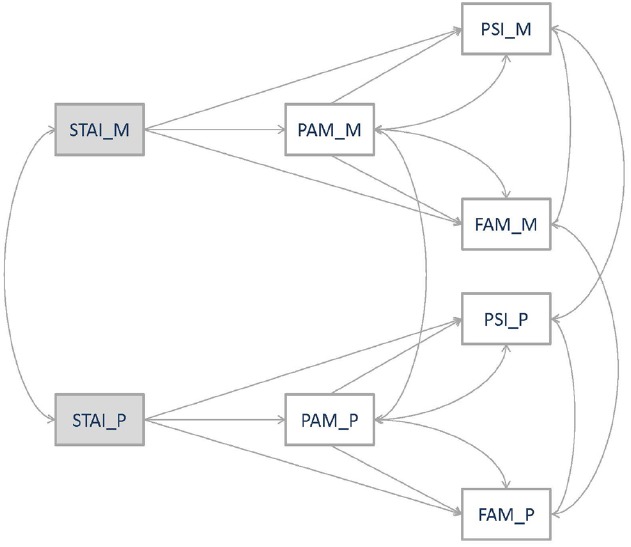
Hypothetical model.